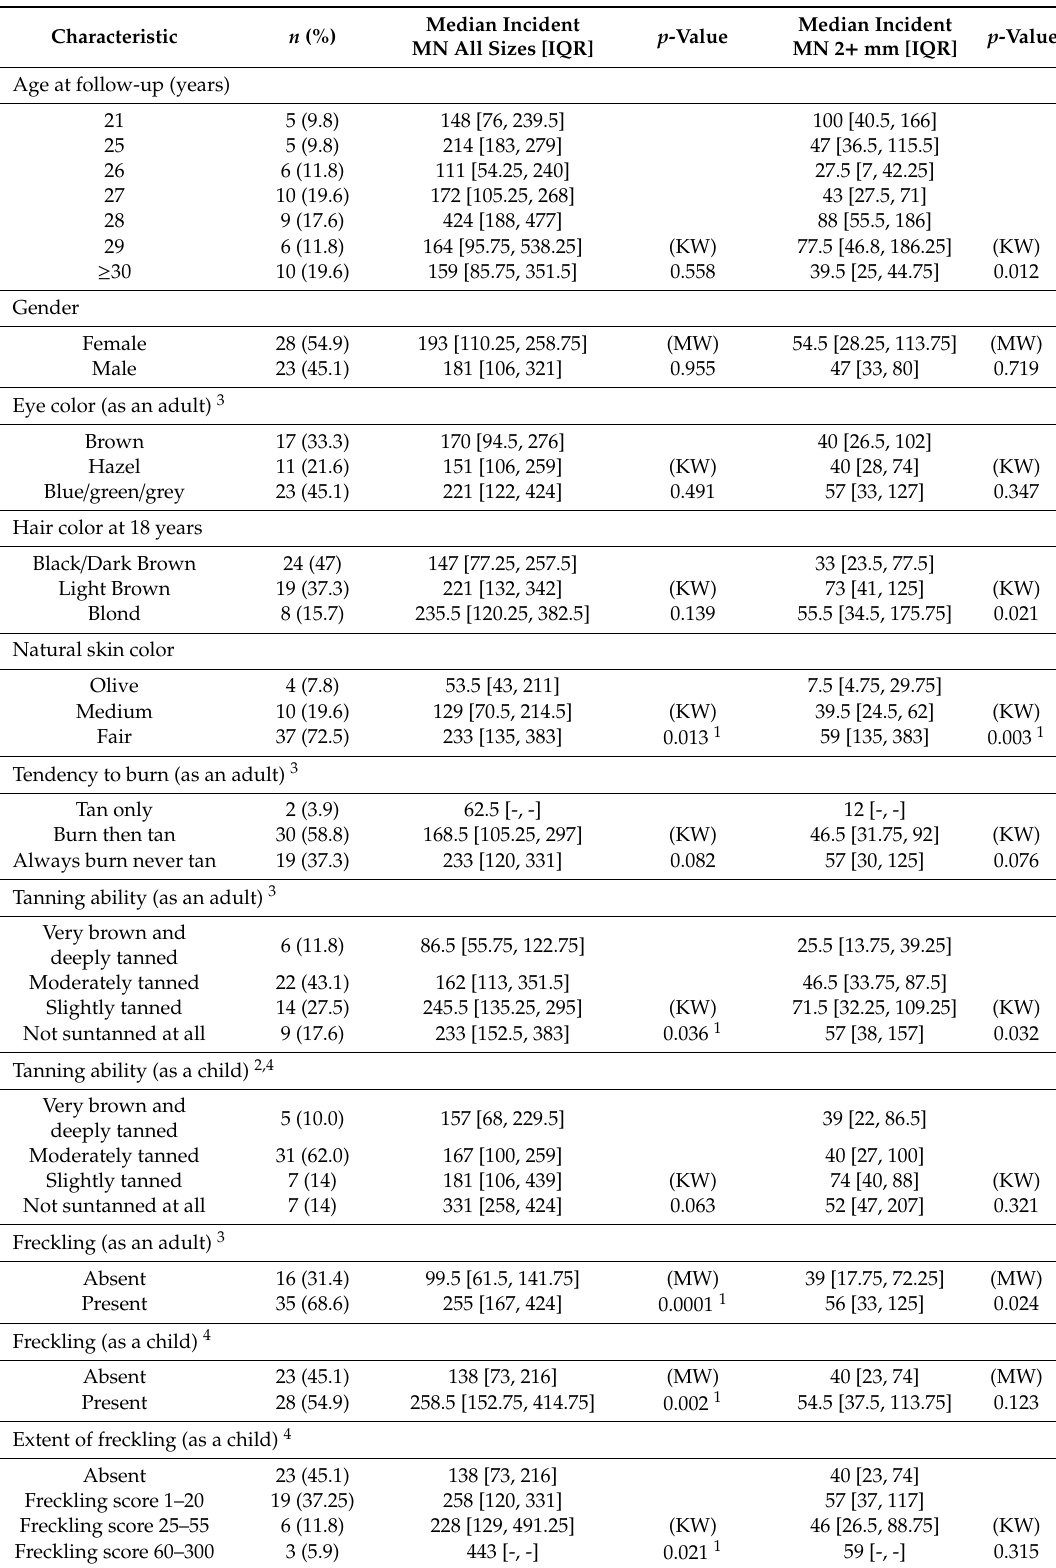
Table 2. Demographic and phenotypic characteristics of participants from the Townsville cohort who were available for follow-up and were re-examined for melanocytic nevi (MN), January–June 2016.